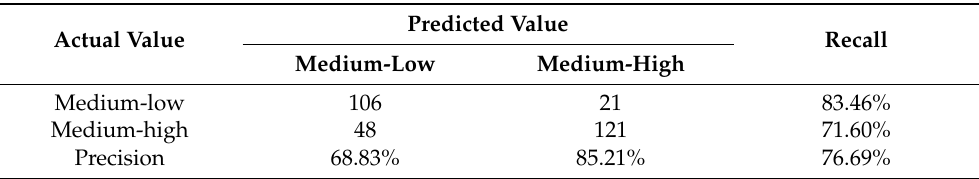
Figure 5. Tree for shear wave velocity liquefaction potential for medium grade (20% < P L < 80%). Table 5. Confusion matrix for medium grade. Table 5. Confusion matrix for medium grade.